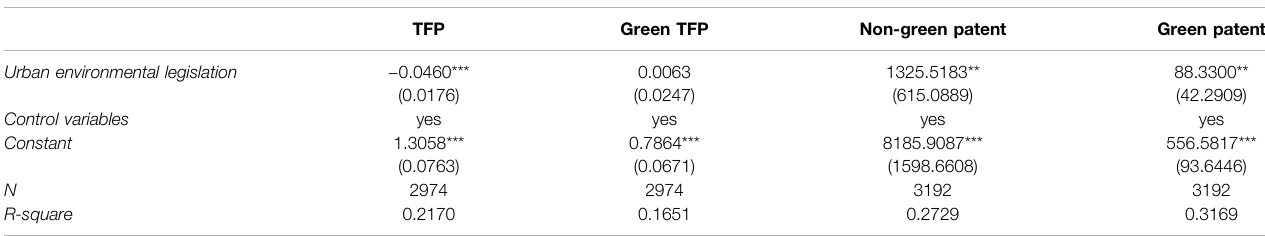
TABLE 7 | Results of policy timing when 2016 is the common policy time